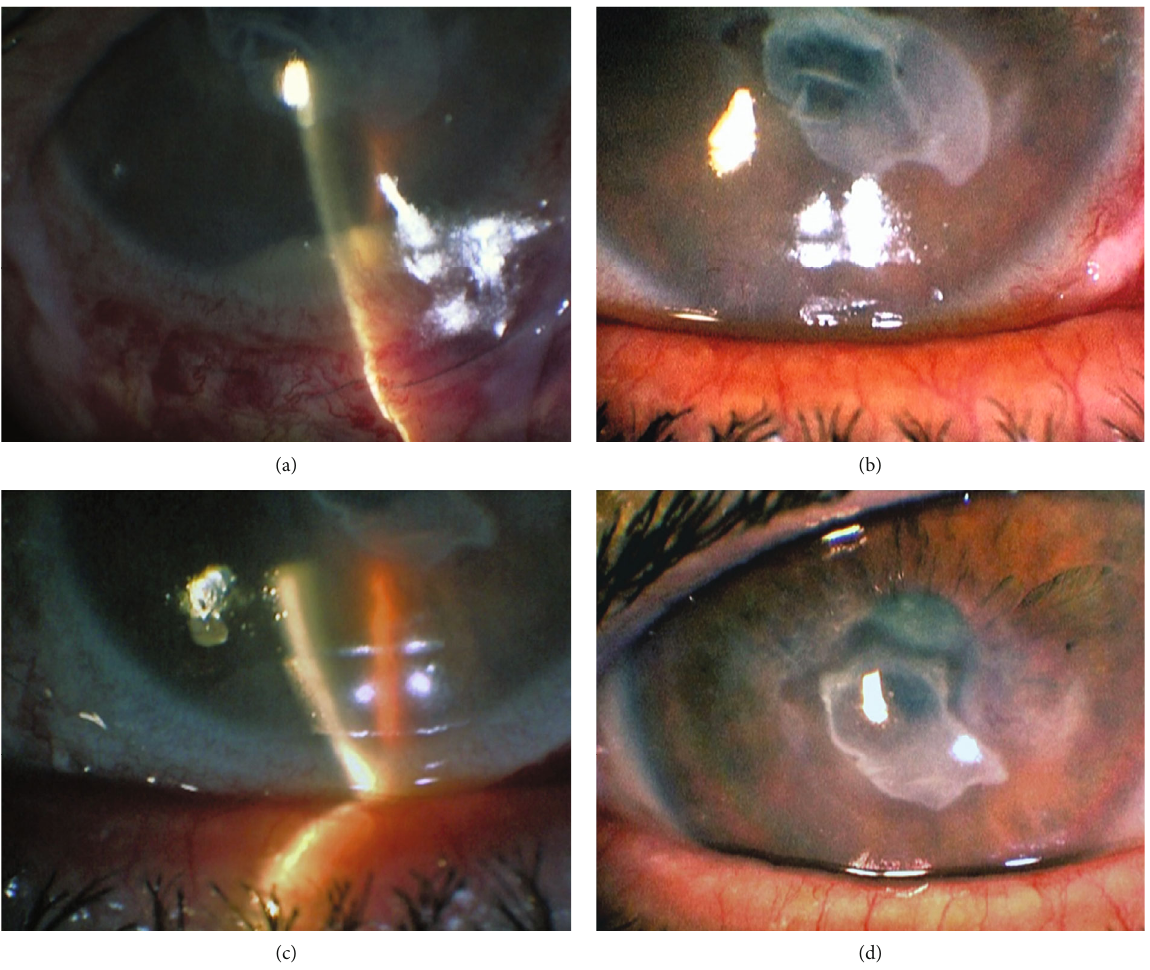
Figure 2: (a) 3mm hypopyon formation 2 days after cryopreserved AMT. (b) Regression of hypopyon one week later. (c, d) Clear anterior chamber with healed ocular surface and no signs of in fl ammation 5 weeks after